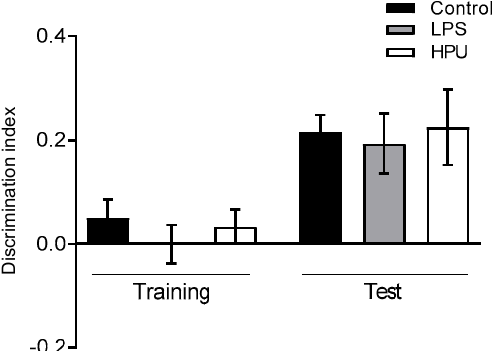
Figure 7. Effect of HPU on memory consolidation. Male Wistar rats received i.p., injections of HPU (5 µg/rat/day), LPS (1 mg/kg/rat/day, positive control) or saline (negative control) for 7 days. Discrimination indexes in the test phase were analyzed by one-way ANOVA followed by Bonferroni’s multiple comparison test. Data expressed as median ± SEM. n = 10 rats/group.